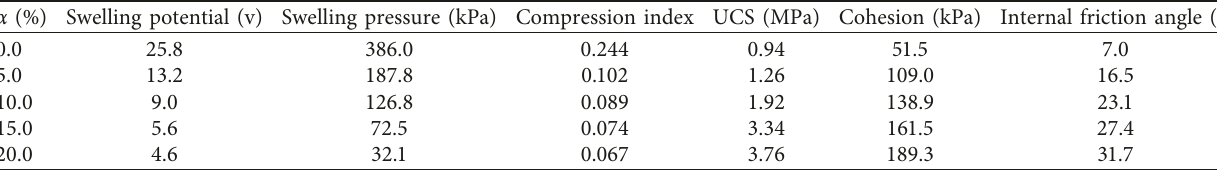
Table 5: The strength and deformation index of stabilized expansive soil.